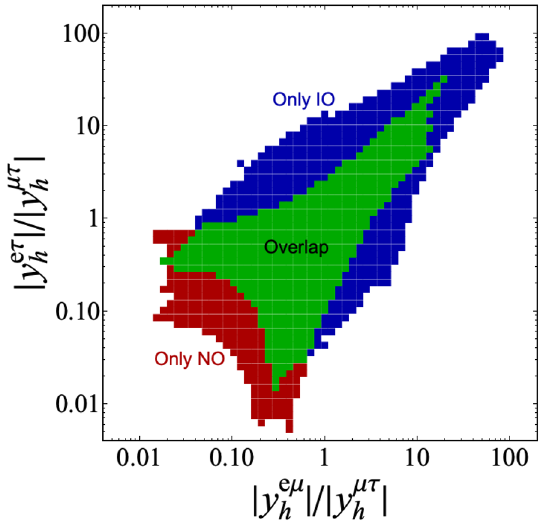
| / | y µτ | and | y eτ | / | y µτ | as obtained in the numerical scan h h h h